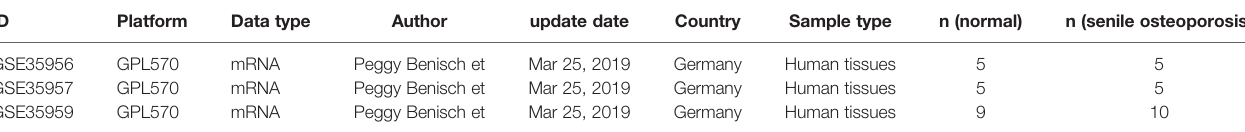
TABLE 1 | Basic information of the microarray